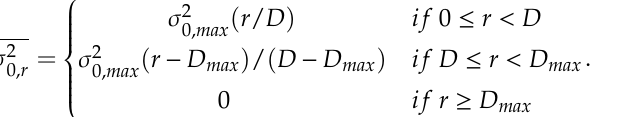
Debye (CD) model (line) ( a ). The sum of CD model and static component (dark blue) is compared with